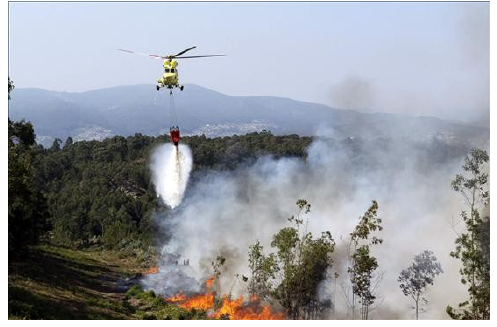
Figure 3. Example of fire extinction using a helicopter.